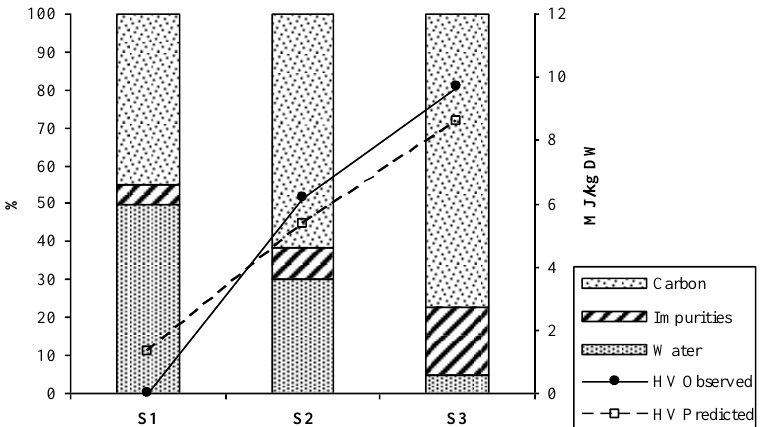
Figure 2. Predicted and observed heating values of dewatered sludge (MJ/kg) of AWWTP with respect to water and heavy metal content of